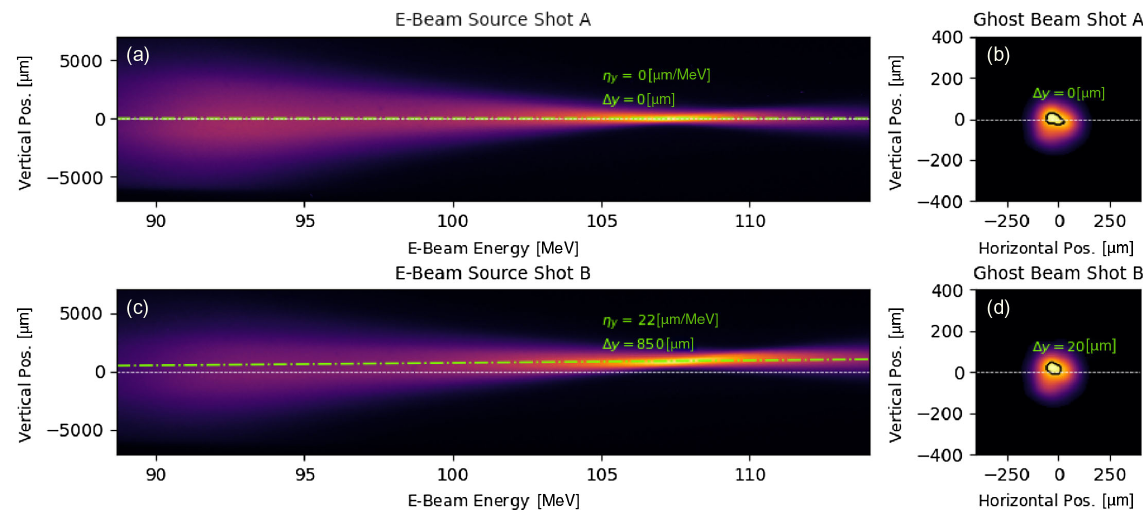
FIG. 2. Shot-to-shot fluctuations of the 1-Hz ghost beam copy (b and d) and the e-beam source (a and c) imaged into the magnetic spectrometer is shown when active stabilization is turned off. The dashed white-colored horizontal lines indicate a nominal design axis while the dashed green-colored lines in plots a and c display the angular tilt of the e-beam brought about by energy-dependent dispersion. We note the intrinsic instabilities present during shot-to-shot firing of an experimental